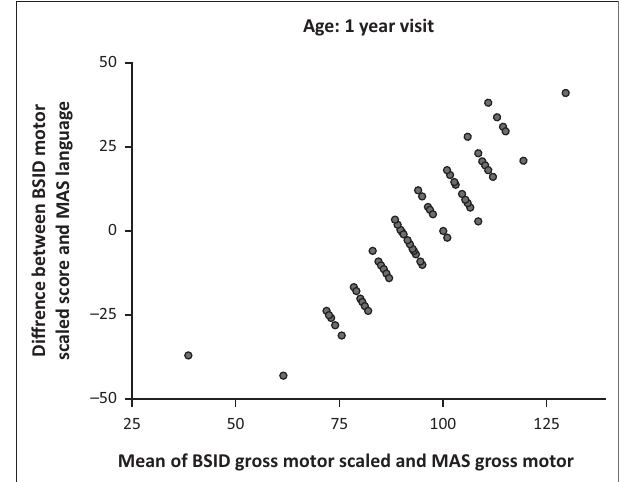
BSID, Bayley Scales of Infant and Toddler Development-third edition; MAS, Molteno Adapted Scale. FIG URE 1: Bland–Altman scatter plot illustrating mean difference between Molteno Adapted Scale and Bayley Scales of Infant and Toddler Development- FIG URE 3: Bland–Altman scatter plot illustrating mean difference between 3rd edition language scores versus Molteno Adapted Scales and Bayley Scales of Molteno Adapted Scale and Bayley Scales of Infant and Toddler Development- Infant and Toddler Development-3rd edition language scores at the 1-year 3rd edition gross motor scores versus Molteno Adapted Scales and Bayley Scales of Infant Development-3rd edition gross motor scores at the 1-year visit. Age: 2–3 year visit